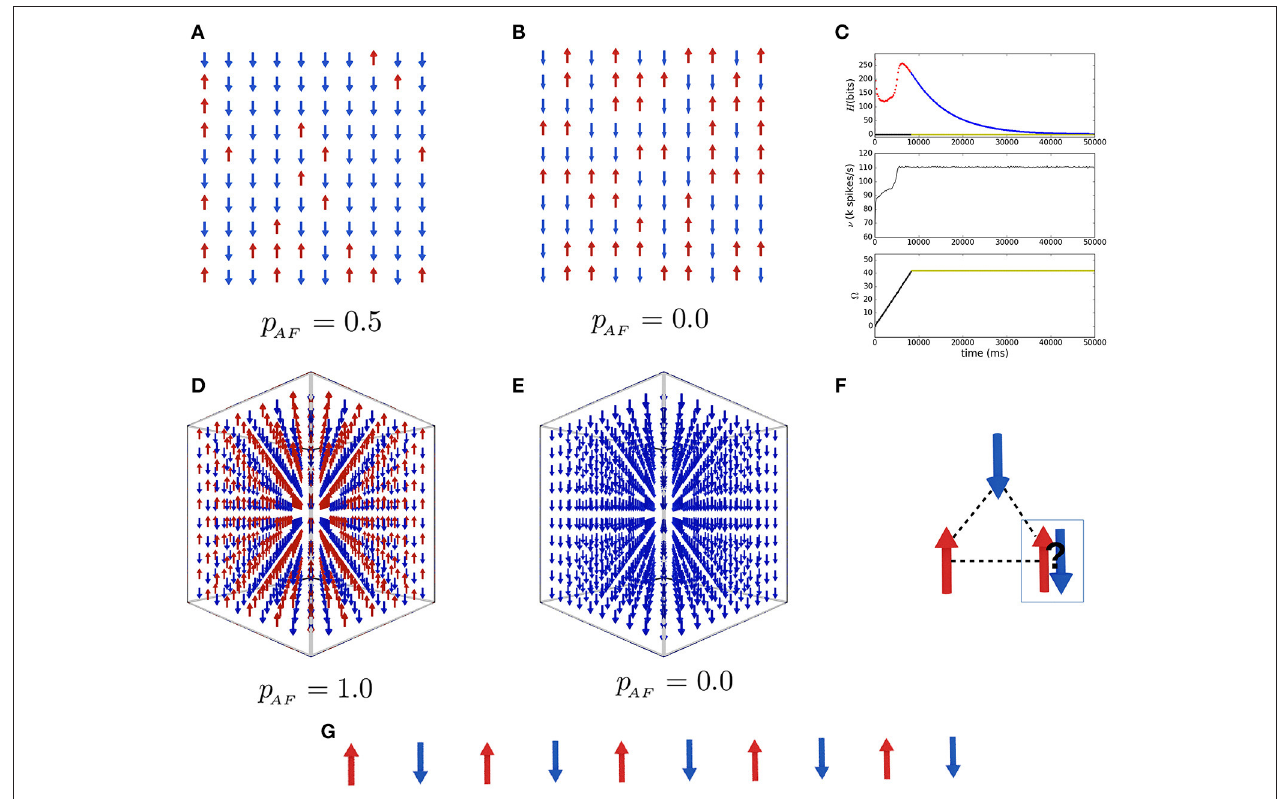
FIGURE 3 | Spiking neural network simulation of Ising spin systems. (A,B) Show two 2-dimensional spin glass quenched states obtained with interaction probabilities p AF = 0.5 and p AF = 0.1. The results for the 3-dimensional lattices for CSPs of 1,000 spins with ferromagnetic and antiferromagnetic coupling constant are shown in (D,E) , respectively. In (C) are plotted the temporal dependence of the network entropy, firing rate ν and states count (cid:127) during the stochastic search for the system in (D) . (F) Illustrates the origin of frustrated interactions in spin glasses. (G) Depicts the result for the 1-dimensional chain. The parameters for the SNNs used are shown in Table 1